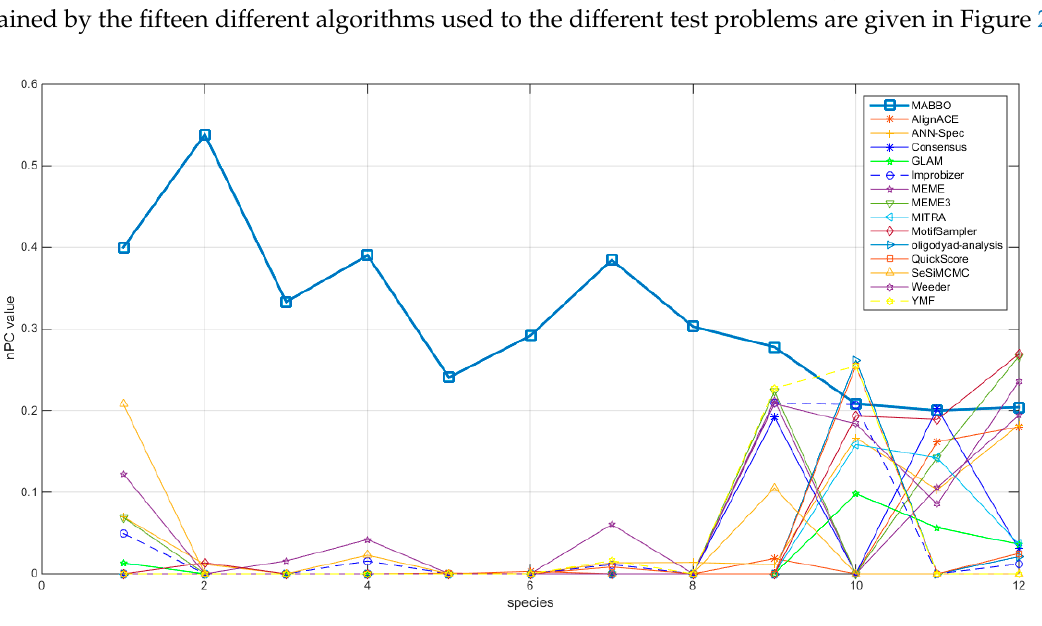
Figure 2. Comparisons of nPC value obtained by MHABBO with other algorithms on different test problems (Dm01g = 1, Dm04g = 2, Dm05g = 3, Hm03r = 4, Hm04m = 5, Hm16g = 6, Mus02r = 7, Mus07g = 8, Mus11m = 9, Yst03m = 10, Yst04r = 11 and Yst08r = 12).